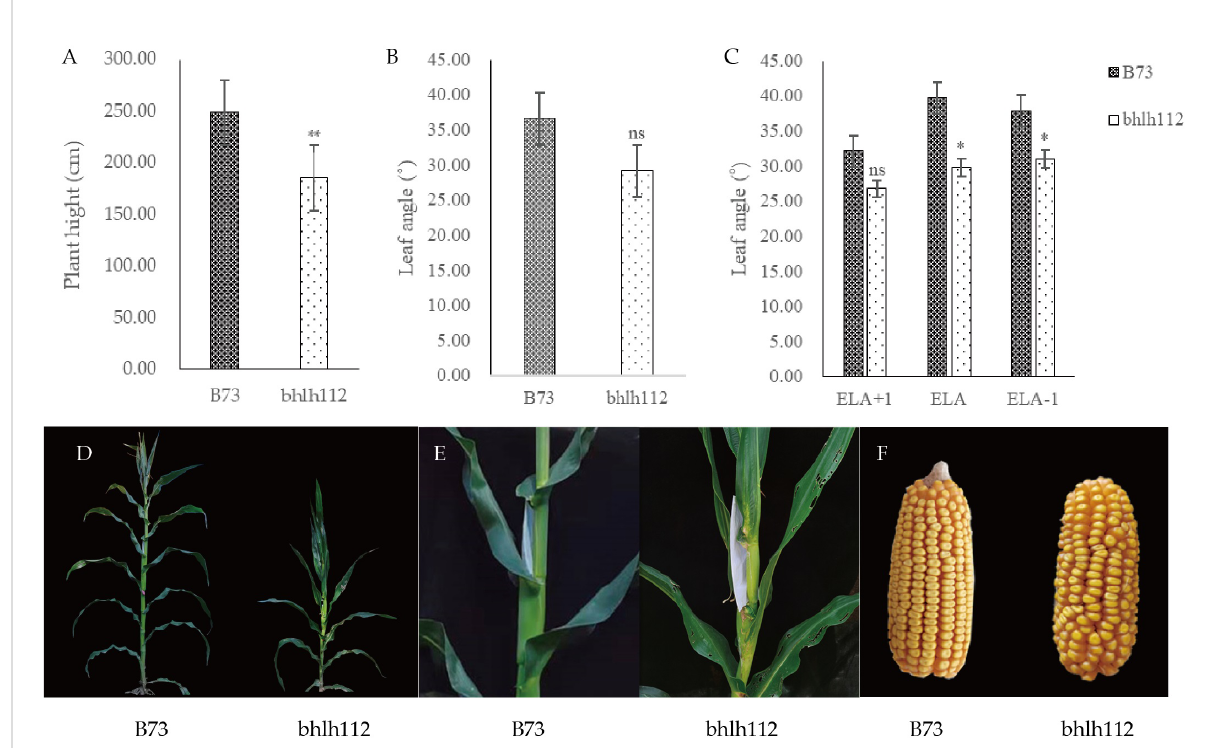
FIGURE 2 Analysis of index of wild-type and mutant bhlh112 . (A) Plant height of mutant and wild-type; (B) Leaf angle of mutant and wild-type; (C) Three ear-leaf-angle of mutant and wild-type at the mature stage. ELA: ear leaf angle; ELA+1: a leaf angle above the ear; ELA-1: a leaf angle below the ear; ns indicates not signi fi cant; (D) Plants at silking stage; (E) Corresponding leaf angle in (D) ; (F) Mature ear of wild type and mutant. * indicates P < 0.05. ** indicates P < 0.01.